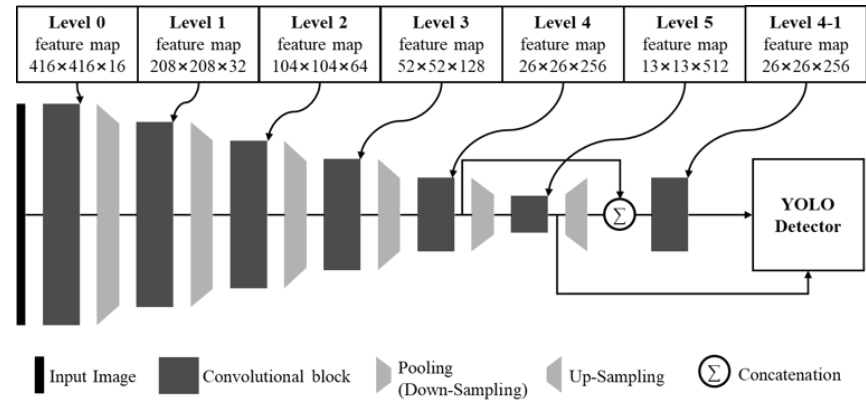
Figure 2. Block diagram of YOLOv3-tiny architecture.